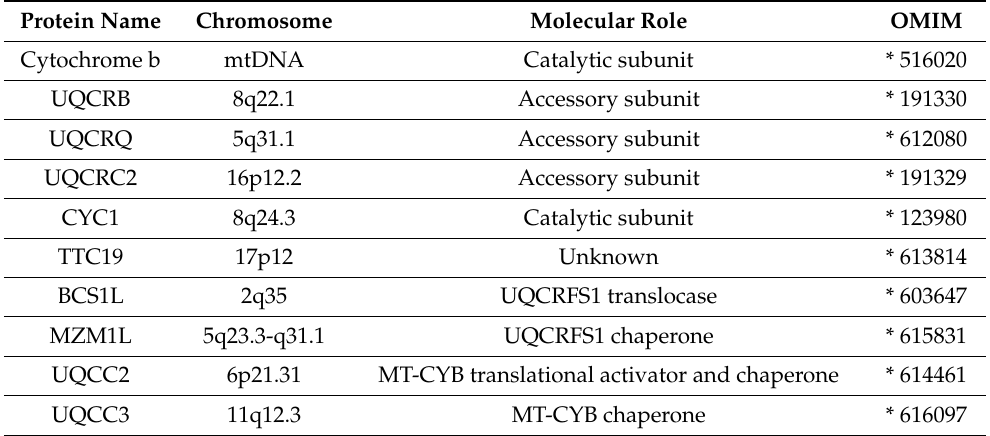
Table 3. Mutations in genes associated with mitochondrial CIII deficiency. Adapted and modified from [24] under the Creative Commons Attribution (CC BY) license. The symbol * in OMIM designates a gene